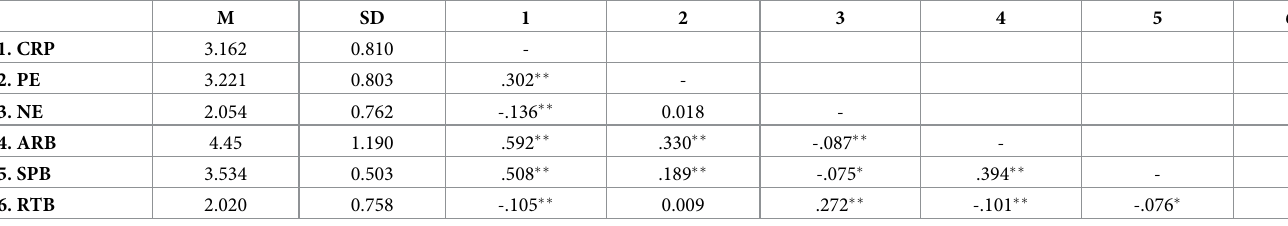
Table 1. Descriptive statistical analysis and correlation analysis results among the variables.